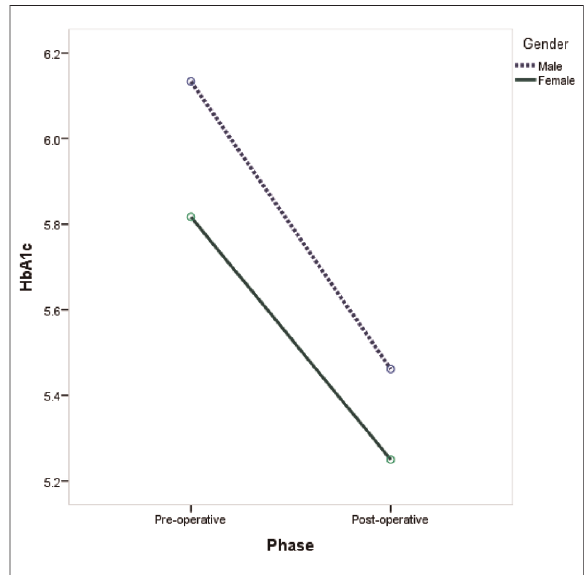
FIGURE 1 Change inn HbA1c before and after laparoscopic sleeve gastrectomy by